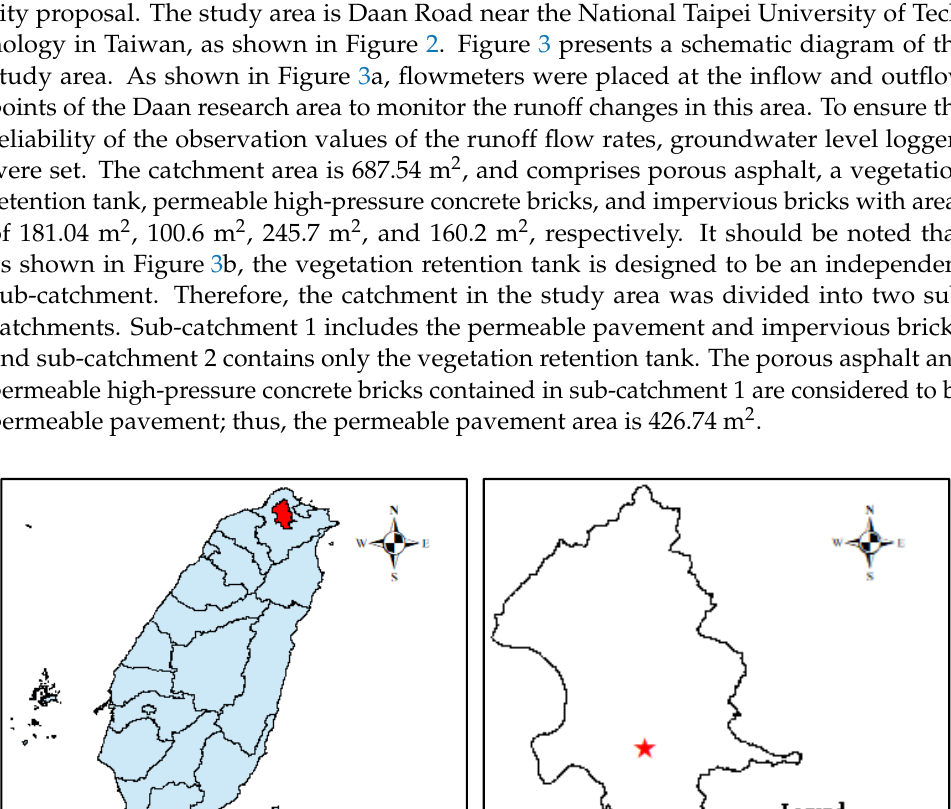
Figure 3. Schematic diagram of the study area: ( a ) onsite monitoring locations; ( b ) photograph of the vegetation retention tank onsite.